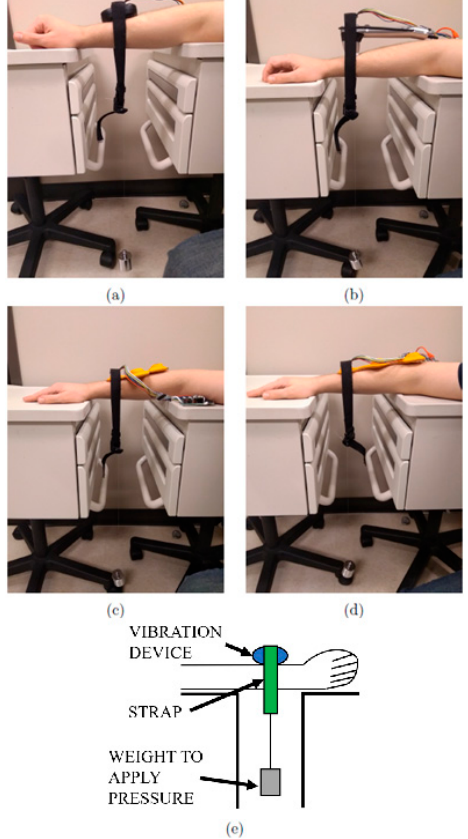
Figure 3. Test setup for constrained vibration using a strap and weight to secure the device, and a weight to apply the vibration with a constant pressure. ( a ) Vibracool, ( b ) Novafon Pro, ( c ) Myovolt three-actuator, ( d ) Myovolt two-actuator, and ( e ) representative constrained